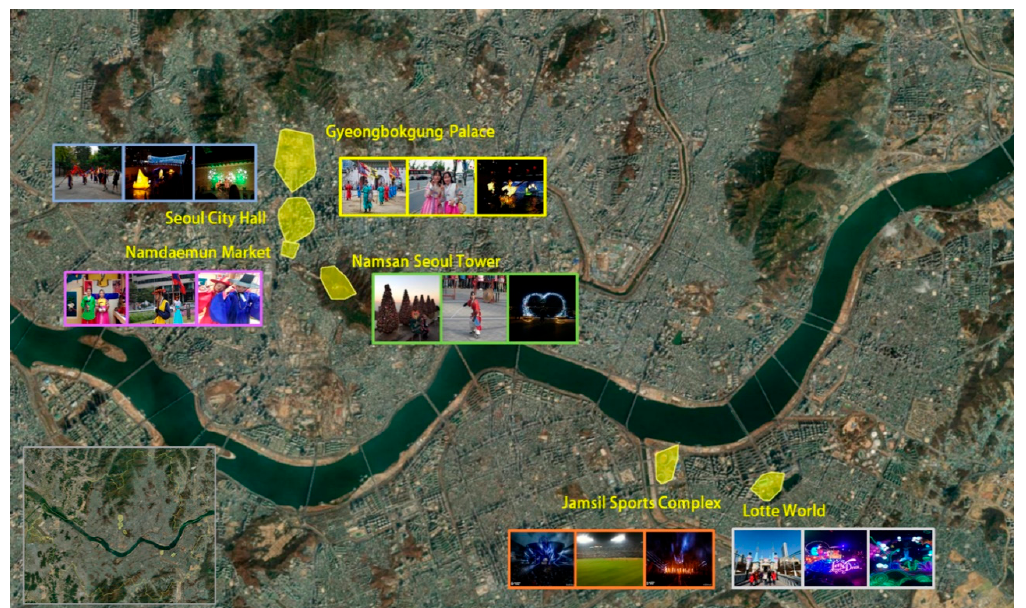
Figure 14. Six regions of attractions for “Activities” category.